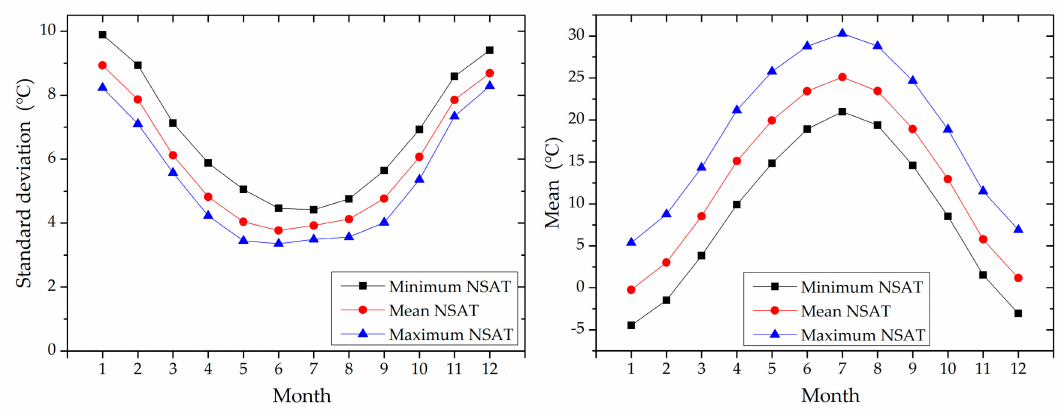
Figure 9. Standard deviation and mean of the monthly mean, maximum, and minimum NSAT at 2132 weather stations in 12 months of